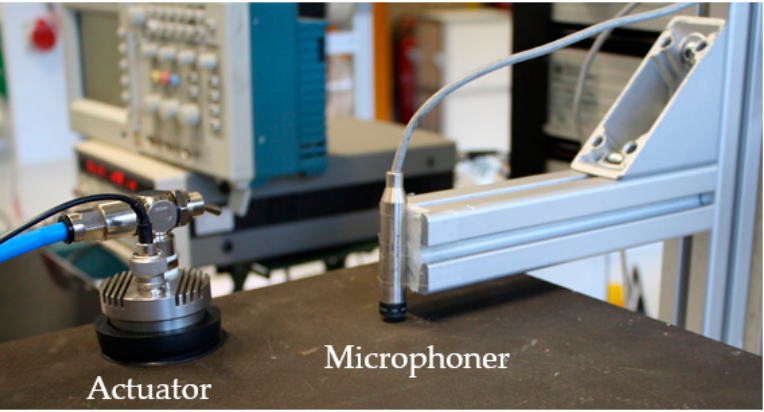
Figure 2. Setup for excitation and microphone RACE detection and defect imaging.